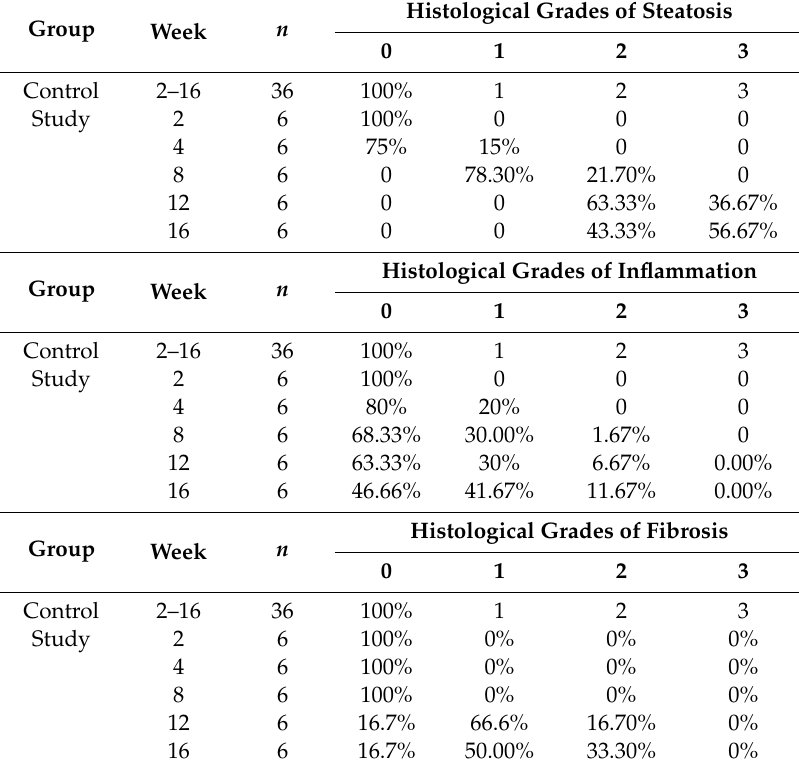
Table 1. Histological evaluation of